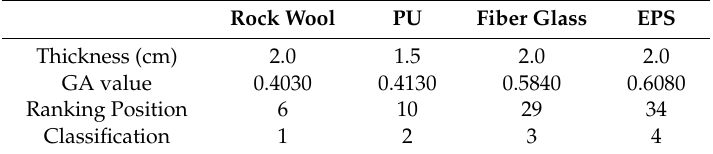
Table 7. Ranking and classification of the insulations following the NBR 15220